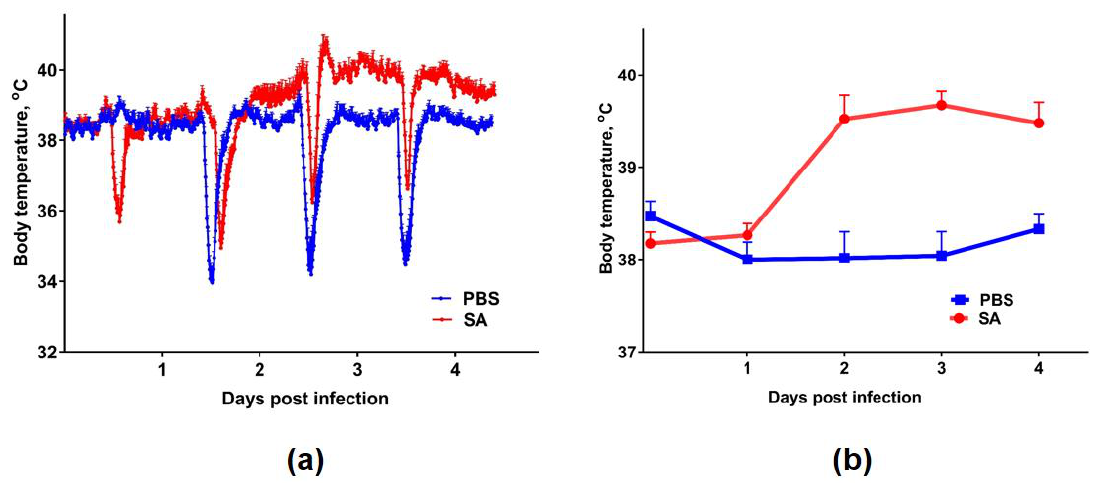
Figure 6. Body temperature of the ferrets after infection with the SA influenza virus: ( a ) variation in the body temperature until 4 days post infection (raw data). The temporary decreases in temperature were the result of sedation during the collection of nasal washes. The body temperature was recorded by temperature loggers every 10 min; ( b ) the difference between the infected group and the control group, represented by the mean ± SD, p < 0.05.